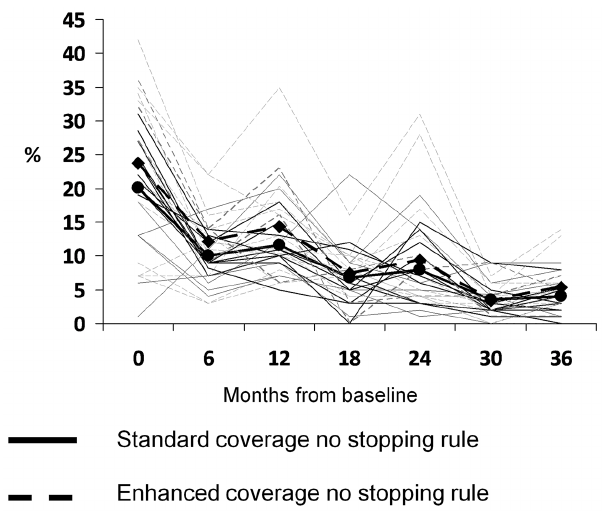
Figure 2. Prevalence of C.trachomatis Infection over time by Coverage